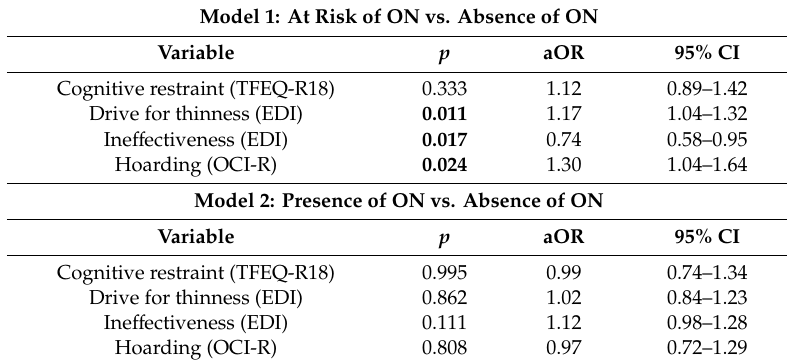
Table 6. Multivariable analysis: multinomial logistic regression taking the absence of orthorexia nervosa as the reference group. Model 1: At Risk of ON vs. Absence of ON